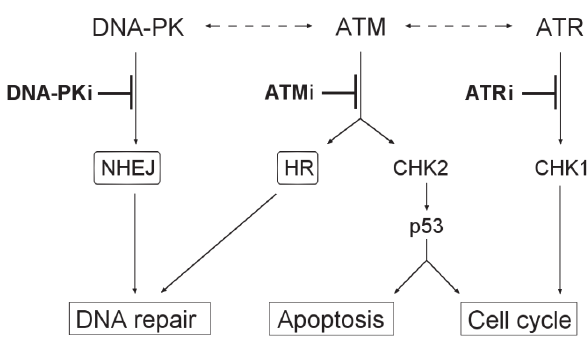
Fig. 1. Scheme of DNA repair kinases inhibition. Important biological consequences of DNA repair kinases in- hibition are shown. DNA-PK phosphorylates DNA ligase IV and/or XRCC4, which may affect their interactions with Ku and other proteins. Thus, inhibition of DNA-PK abrogates NHEJ and impacts DNA repair similarly to inhibition of ATM, which is a key regulator of HR. ATM is required in the initiation of HR for it phosphorylates number of downstream targets such as H2AX, BRCA1, MRN complex, etc. Therefore, ATM inhibi- tion leads to accumulation of DNA damage, too. Additionally, ATM affects apoptosis and cell cycle progression indirectly via phosphorylation of CHK2 or directly via phosphorylation of transcriptional factor p53. The essential role of ATR is regula- tion of cell cycle progression to the G phase via phosphoryla- 2 tion of CHK1. Additionally, mutual cross-talks and interactions of the given kinases have been proved, too. ATM, ataxia-telangiectasia mutated kinase; ATR, ATM-Rad3- related kinase; BRCA1, breast cancer 1 protein; CHK1/2, check- point kinase-1/2; DNA-PK, DNA-dependent protein kinase; protein complex; NHEJ, non-homologous end